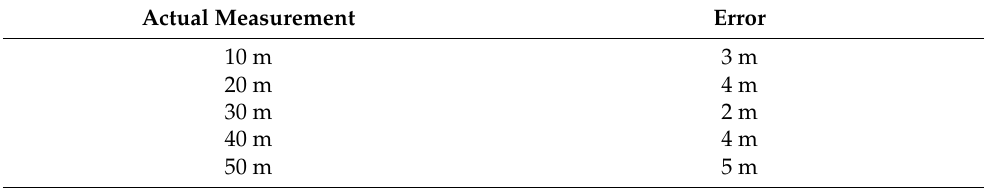
Table 1. DenseDepth cavity depth-value error.